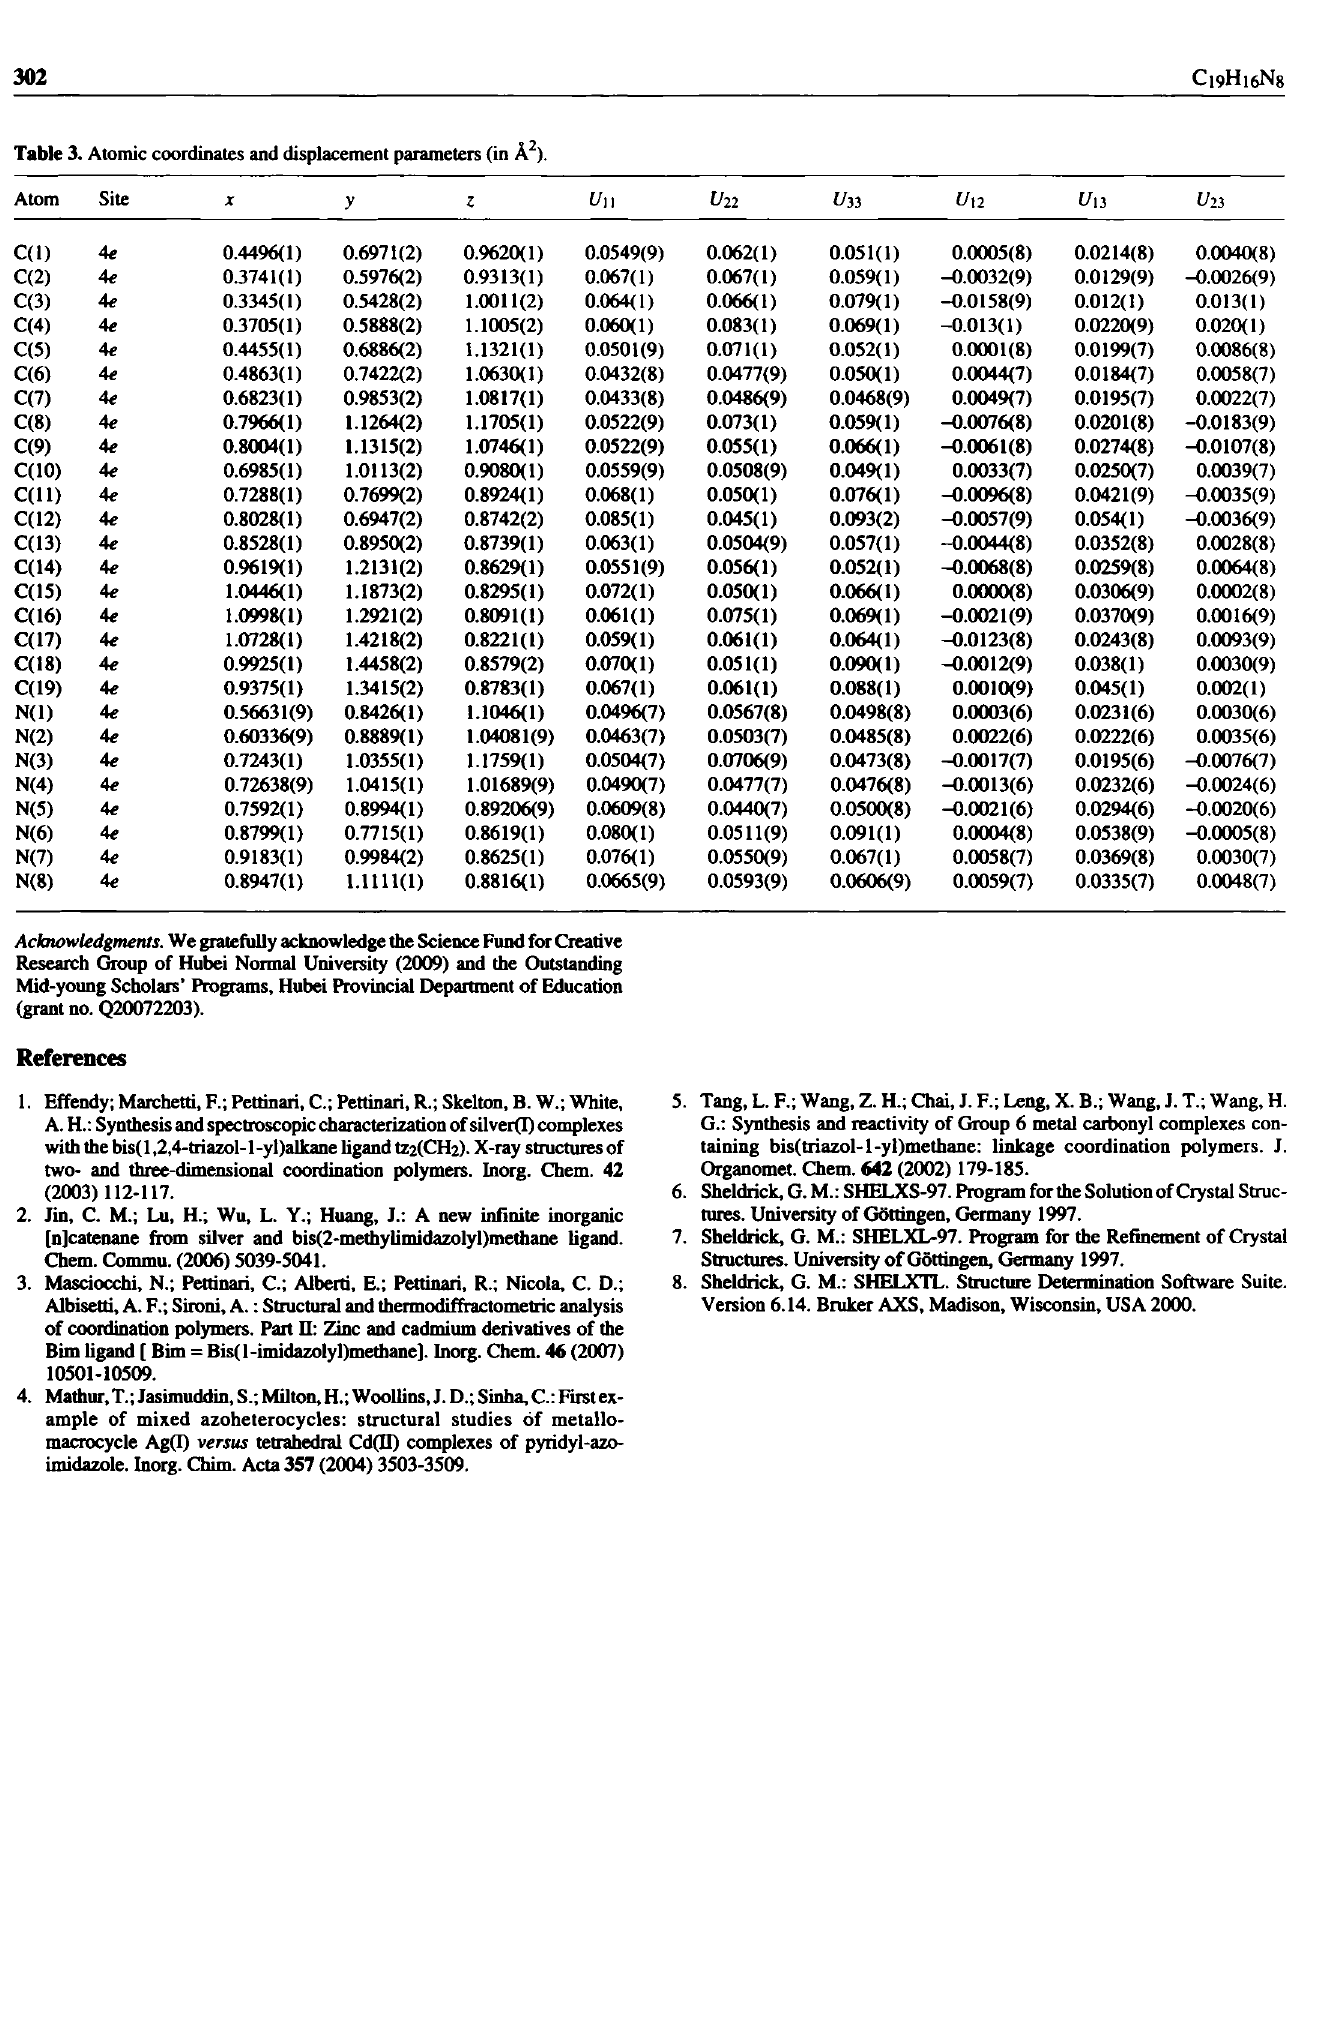
Table 3. Atomic coordinates and displacement parameters (in Ä 2